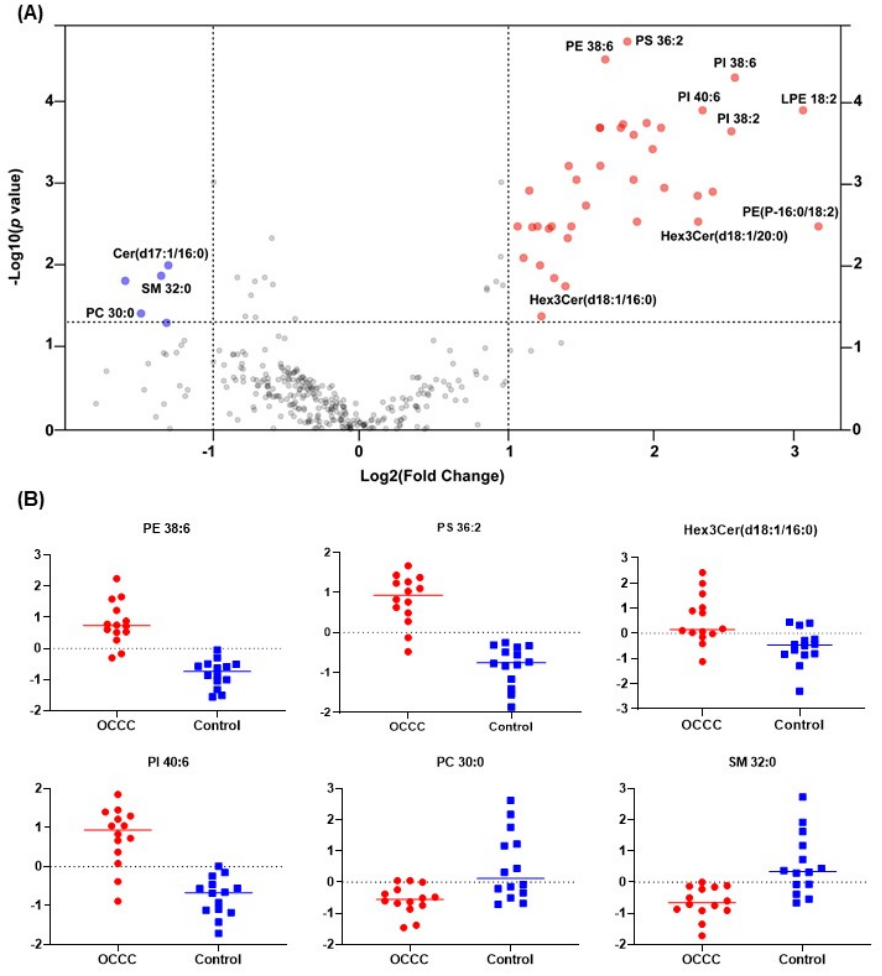
Figure 2. ( A ) Volcano plot showing lipid species that are significantly increased (red) or decreased (blue) in OCCC compared to control, p < 0.05 (FDR adjusted). ( B ) Individual dot plots of representative lipid species from several lipid classes showing differential expression in OCCC compared to control.